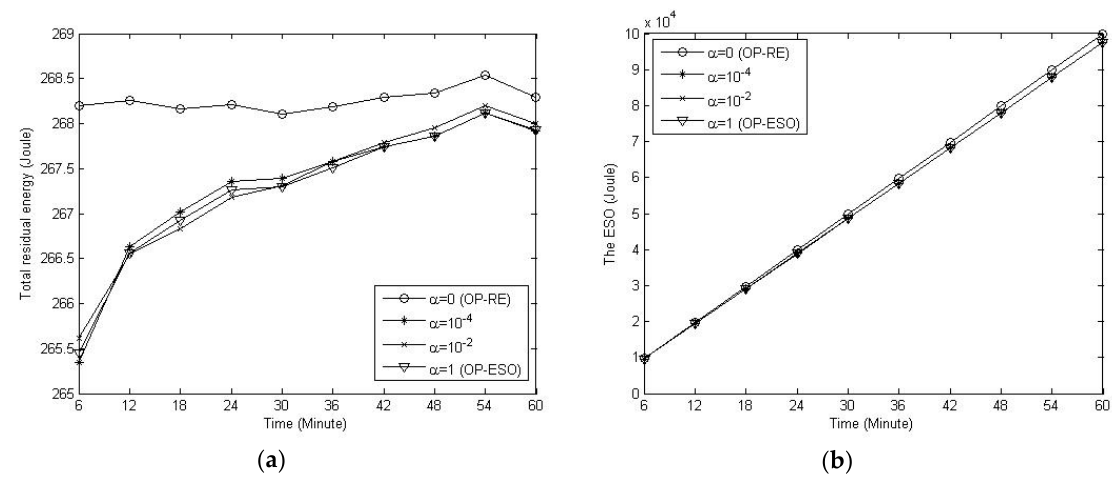
Figure 9. The ESO-aware multiple path (EAMP) scheme with variation in α . ( a ) Impact of α on residual energy; ( b ) Impact of α on ESO.